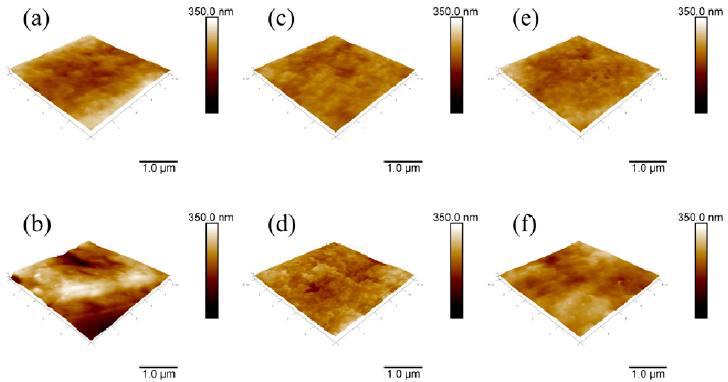
Figure 3. Surface topography by atomic force microscope (AFM): ( a ) PE; ( b ) PET; ( c ) PEH; ( d ) PEF; ( e ) PETH; and ( f ) PETF.